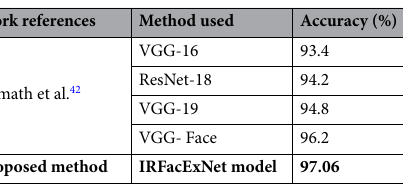
Table 5. Summary of results for Tufts face database. Bold value indicates name and accuracy of the proposed